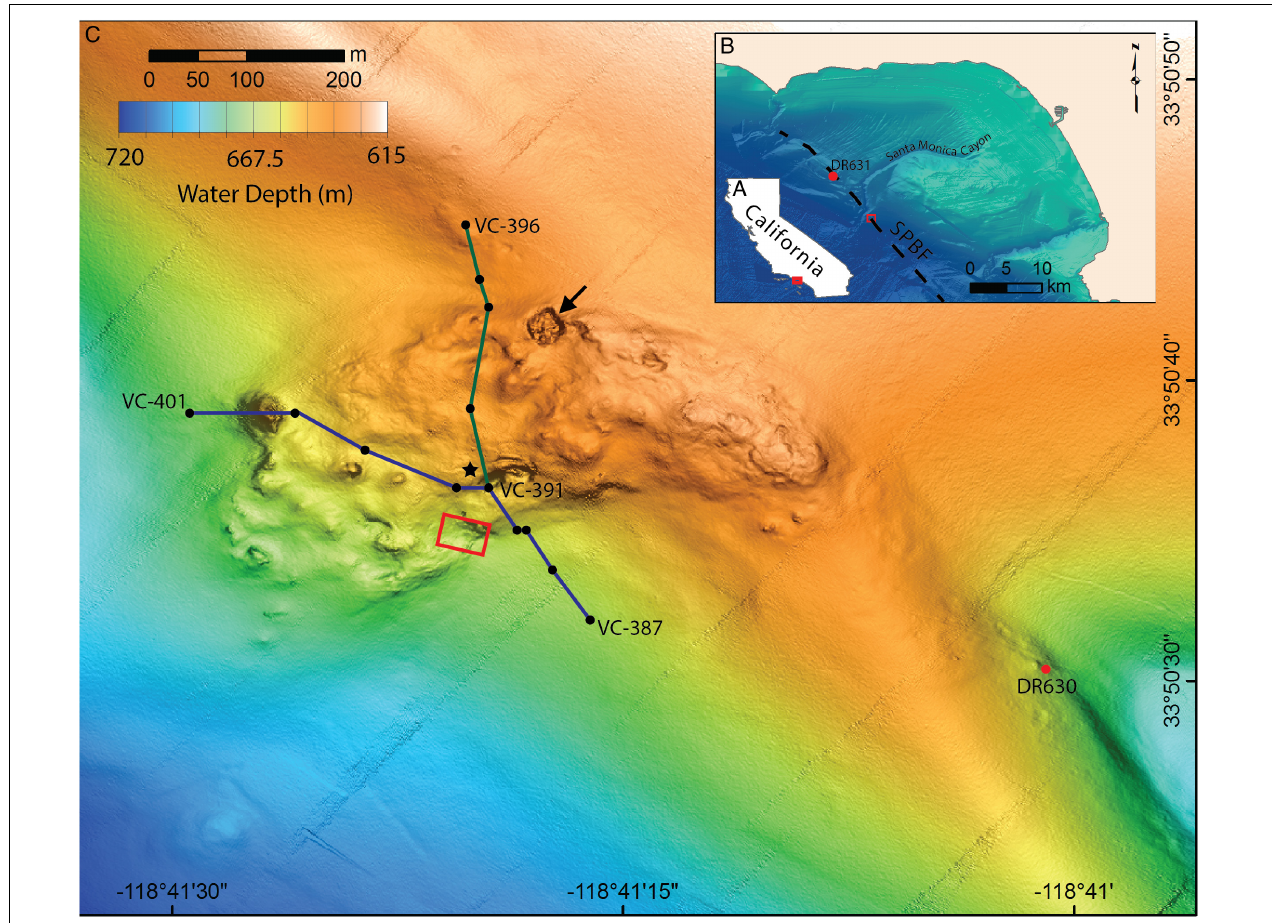
FIGURE 1 | Location and bathymetry of Fossil Hill. (A) Map of California showing the location of the Santa Monica Bay area, red box shows area pictured in B . (B) Santa Monica Bay showing the location of Fossil Hill (red box, pictured in detail in C ) in relation to the Santa Monica canyon and the approximate position of the San Pedro Basin fault (SPBF, dashed black line; Ryan et al., 2012). The location of the sampling site northeast of Fossil Hill (DR631) is also shown. (C) Detailed bathymetry of the Fossil Hill mound. Blue and green lines show the tracks of the elevation profiles in Figure 6 . The black dots within these tracks represent individual vibracore locations, with start, and end vibracore numbers labeled. Red box shows area in which video-mosaic ( Figure 3 ) was performed. Black star denotes the location of an extensive live clam and bacterial mat bed, and a large pockmark (27 m wide, 4 m deep) on the northern margin is indicated with an arrow. The sampling site southeast of Fossil Hill (DR630) is